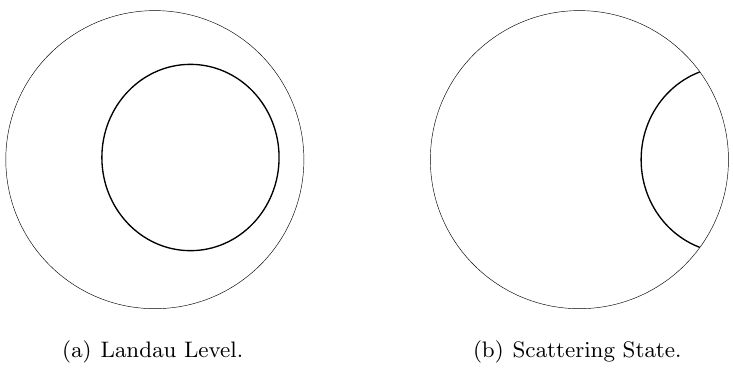
Figure 10 . Particle in real magnetic